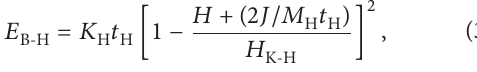
Figure2:Normalized 𝐻 ECC bilayer, and proposed ECC